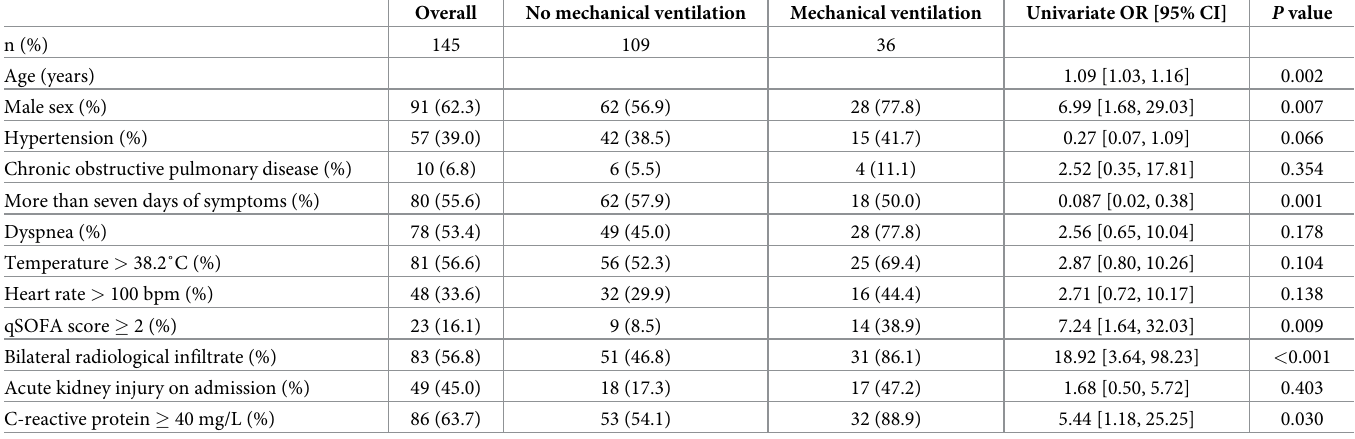
Table 8. Adjusted risk factors associated with mechanical ventilation at 14